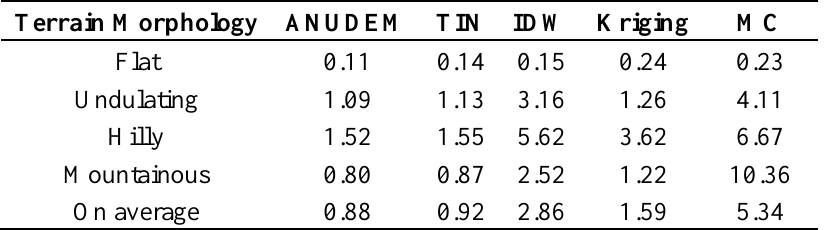
Table 4. RMSEs of triangular with linear interpolation (TIN), inverse distance weighting (IDW), kriging with pre-fitted variogram and minimum curvature (MC) in the four study sites (unit: